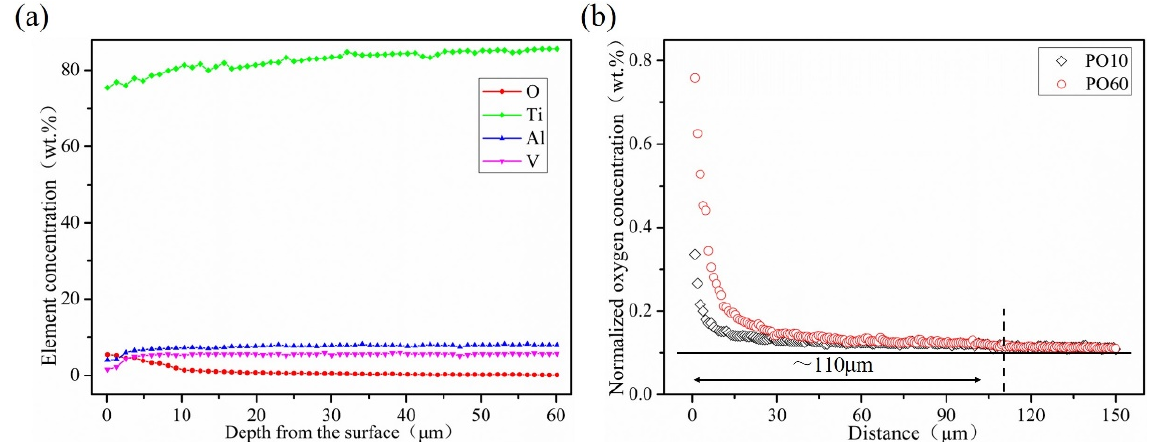
Figure 4. ( a ) Concentration distribution of main elements and oxygen near the surface of PO60 and ( b ) normalized oxygen concentration distribution of PO10 and PO60.